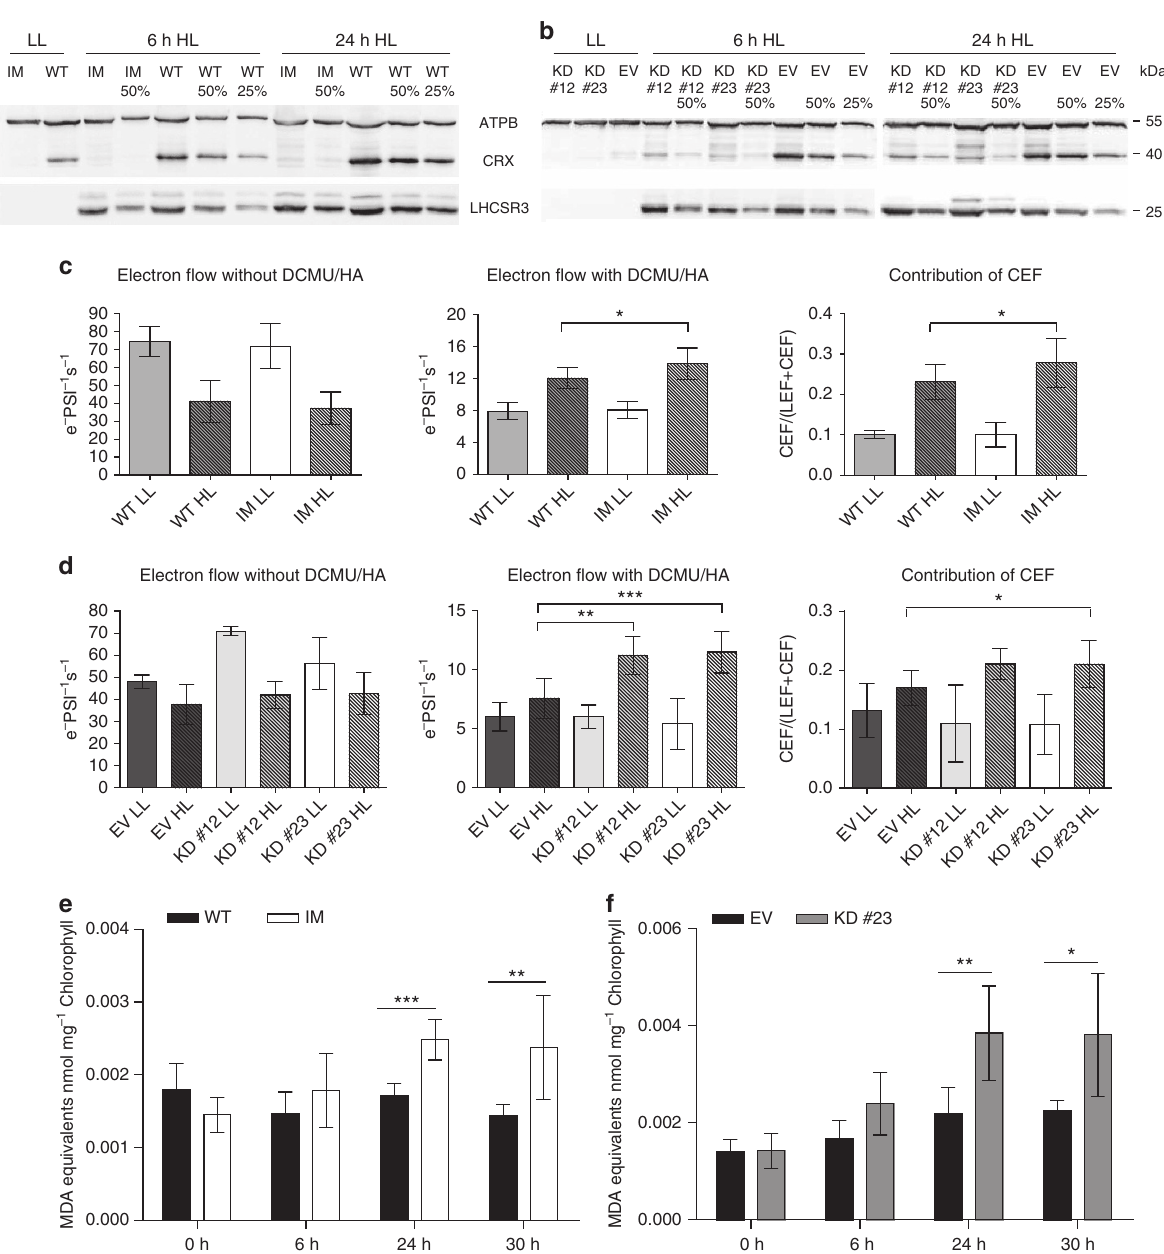
Figure 5 | Calredoxin function in vivo . ( a , b ) Immunoblot analysis of WTversus IM crx ( a ) or empty vector (EV) versus amiRNA-crx-12/23 (KD#12/KD#23) ( b ) whole-cell extracts. ATPB, LHCSR3 and CRX protein expression were examined in cells grown under photoheterotrophic (TAP) LL (30 m Em (cid:2) 2 s (cid:2) 1 ), which were shifted to photoautotrophic (HSM) HL (180 m Em (cid:2) 2 s (cid:2) 1 ) growth conditions. Chlorophyll (1.5 m g) were loaded per lane and equate 100%. ATPB was used as loading control. ( c , d ) Comparison of linear photosynthetic electron flow and CEF in WTversus IM crx ( c ) or EVversus KD#12 and KD#23 ( d ) cells grown under TAP/LL, which were shifted for 6h either to HSM/LL or HSM/HL growth conditions. LL and HL data ( ± s.d.) refer to analyses of three biological replicates for WTand IM crx , with 5 and 11 as well as 6 and 12 measurements, respectively; KD LL Data ( ± s.d.) refer to analyses of three biological replicates for EV, KD#12 and KD#23 with three measurements each; HL Data ( ± s.d.) refer to analyses of three (EV), three (KD#12) and seven (KD#23) biological replicates, with three, nine and 10 measurements, respectively. For statistical analysis of indicated data t -test with * P o 0.05, ** P o 0.01 and *** P o 0.001 was performed. ( e , f ) Measurement of lipid peroxidation in calredoxin-deficient strains under HL conditions. WTversus IM crx ( e ) and of empty vector (EV) versus KD#23 ( f ) cells after transition from TAP/LL to HSM/HL growth conditions. Malondialdehyde equivalents were measured from whole cells (4 m gChlml (cid:2) 1 ) before (0h, grown in TAP at 30 m Em (cid:2) 2 s (cid:2) 1 ) and after HL treatment (shifted to HSM for 6, 24, 30h at 180 m Em (cid:2) 2 s (cid:2) 1 ). WTversus IM crx data refer to four biological replicates with eight measurements each, EV versus KD#23 data refer to analyses of three biological replicates with six measurements each. Error bars represent s.d.’s. Statistical comparison of indicated data was done using t -test with * P o 0.05, ** P o 0.01 and *** P o